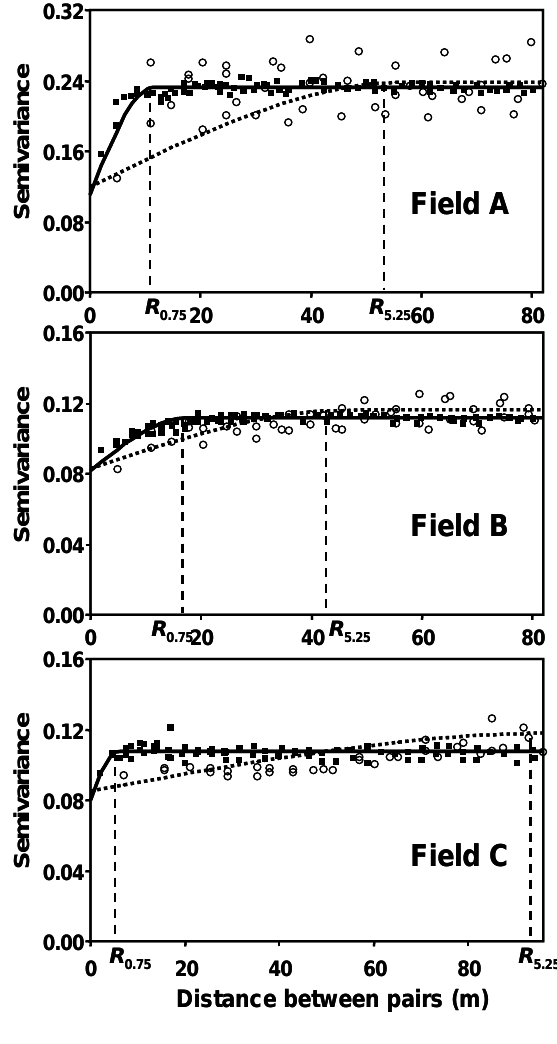
Figure 2. Empirical semivariograms for data obtained with sensors spaced 0.75 m (in all crop rows; square points) and with sensors spaced 5.25 m (one sensor every seven crop rows; circle points) for the north-south direction (along crop rows). Curve lines represent fitting of exponential models for sensors spaced 0.75 m (solid line) and 5.25 m (dotted line). The values of the ranges ( R and R for semivariograms with sensors spaced 0.75 0.75 5.25 and 5.25 m, respectively) coincide with the points where the vertical dashed lines intersect on the X